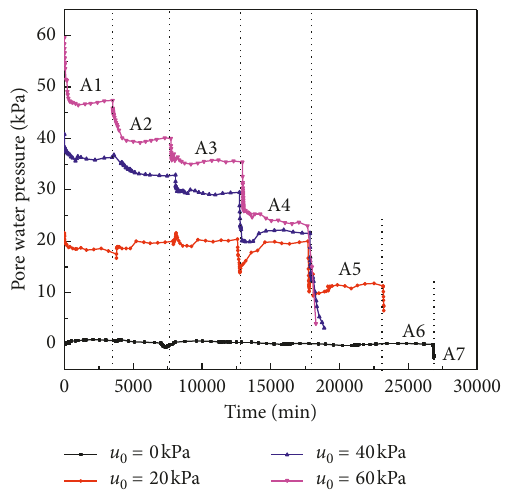
Figure 4: The pore water pressure-time curve at different pore water pressures.